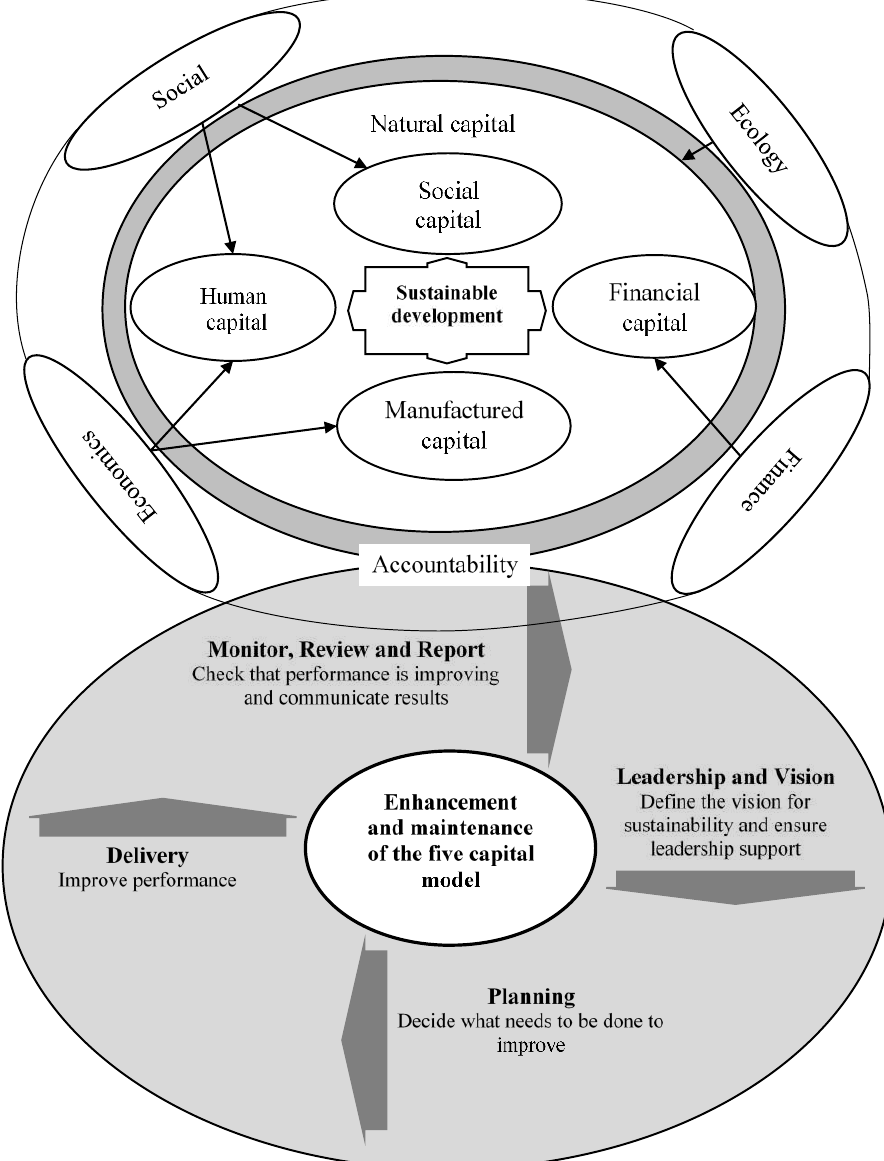
Fig. 5. Harmonization of the modern sustainable development concept and the five capital